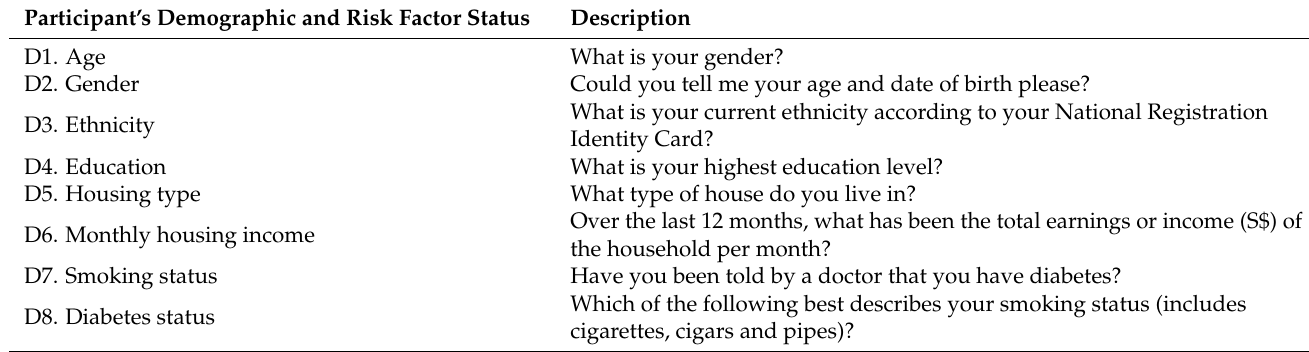
Table 1. Components of the self-reported periodontal screening